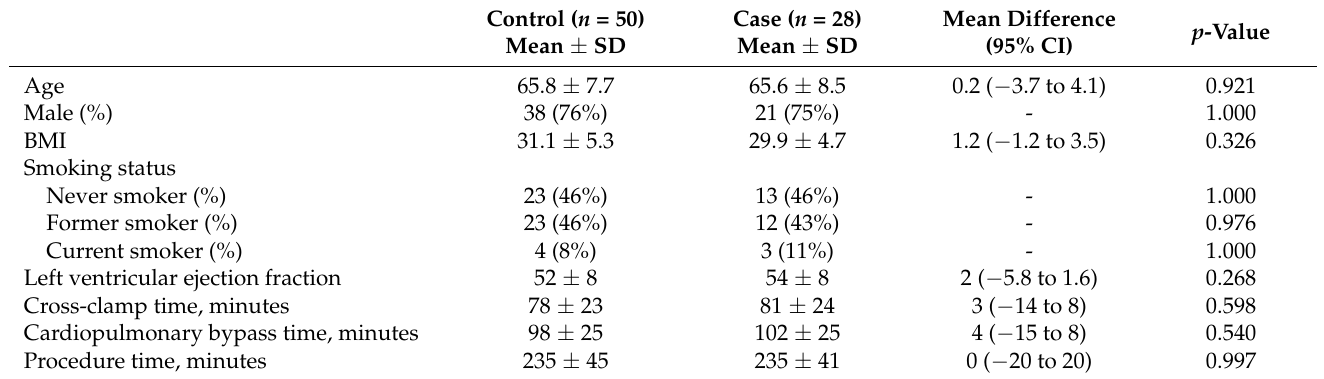
Table 1. Demographic data and procedural